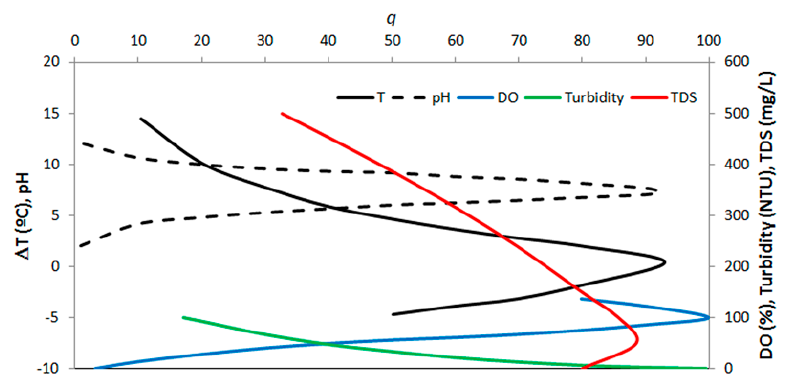
Figure 5. Standardization curves used to transform the water quality parameters into q scores (Equation (1)). Source: https://cetesb.sp.gov.br. Table 3. Average water quality based on the five parameters used to calculate the IWQ (Index for Water Quality) index (Equation (1)). The full inventory of values, obtained within the monitoring period (January 2016–January 2017), is provided as Supplementary Material.